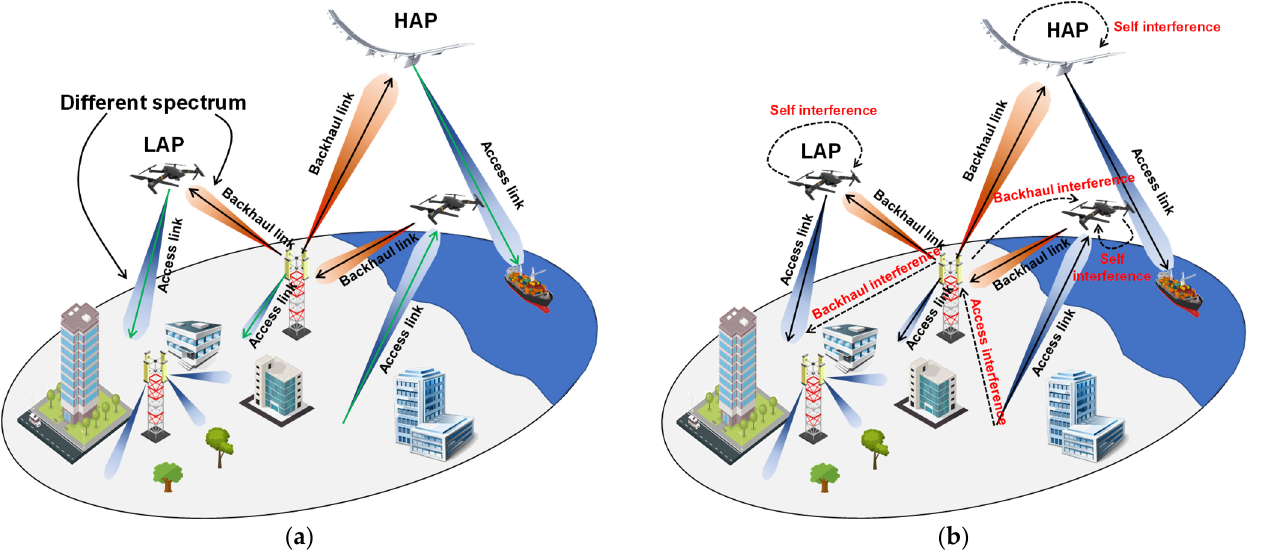
Figure 5. Example of ( a ) Half-Duplex (HD) and ( b ) Full-Duplex (FD) wireless communication through ground and airborne segment.